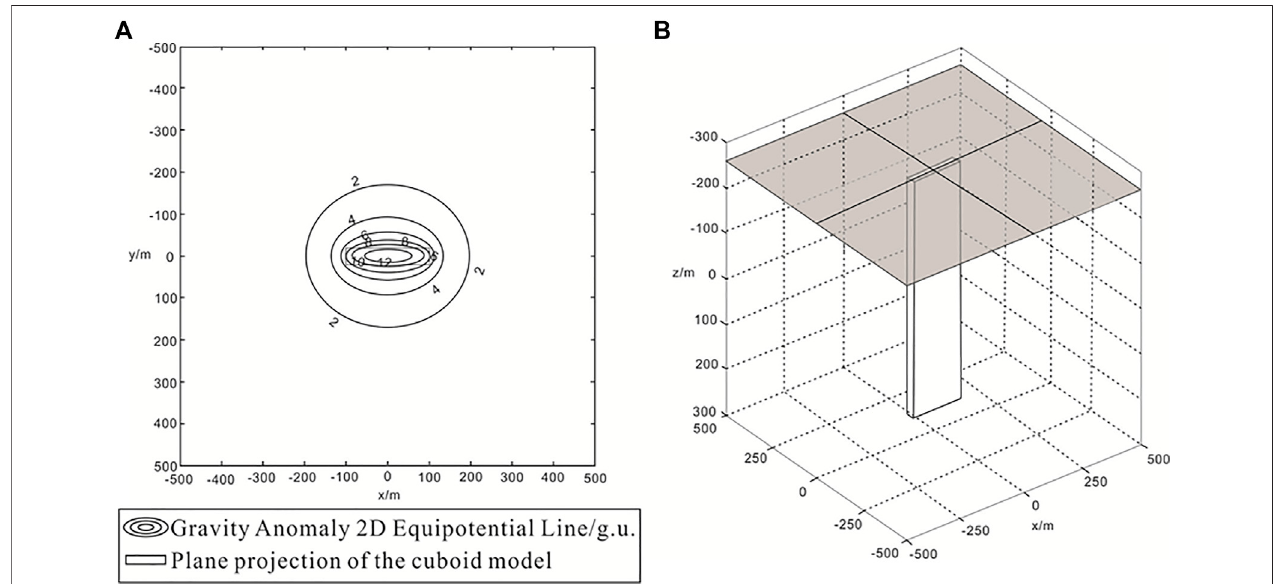
FIGURE 3 | Contour map of the gravity anomaly on the observation plane at z = -260